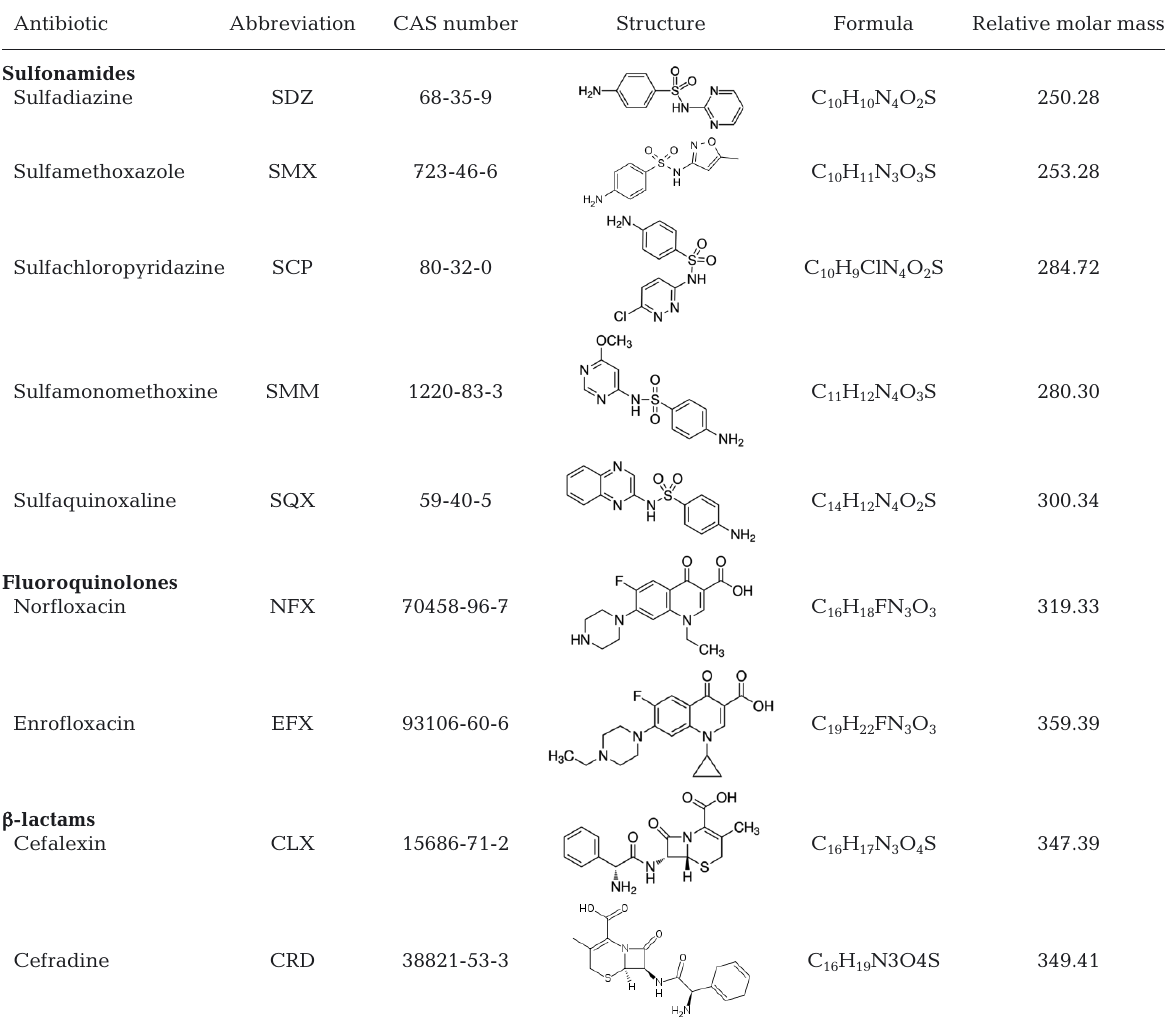
Table 1. Chemical information for the widely used aquaculture antibiotics tested in the present study. CAS: Chemical Abstracts